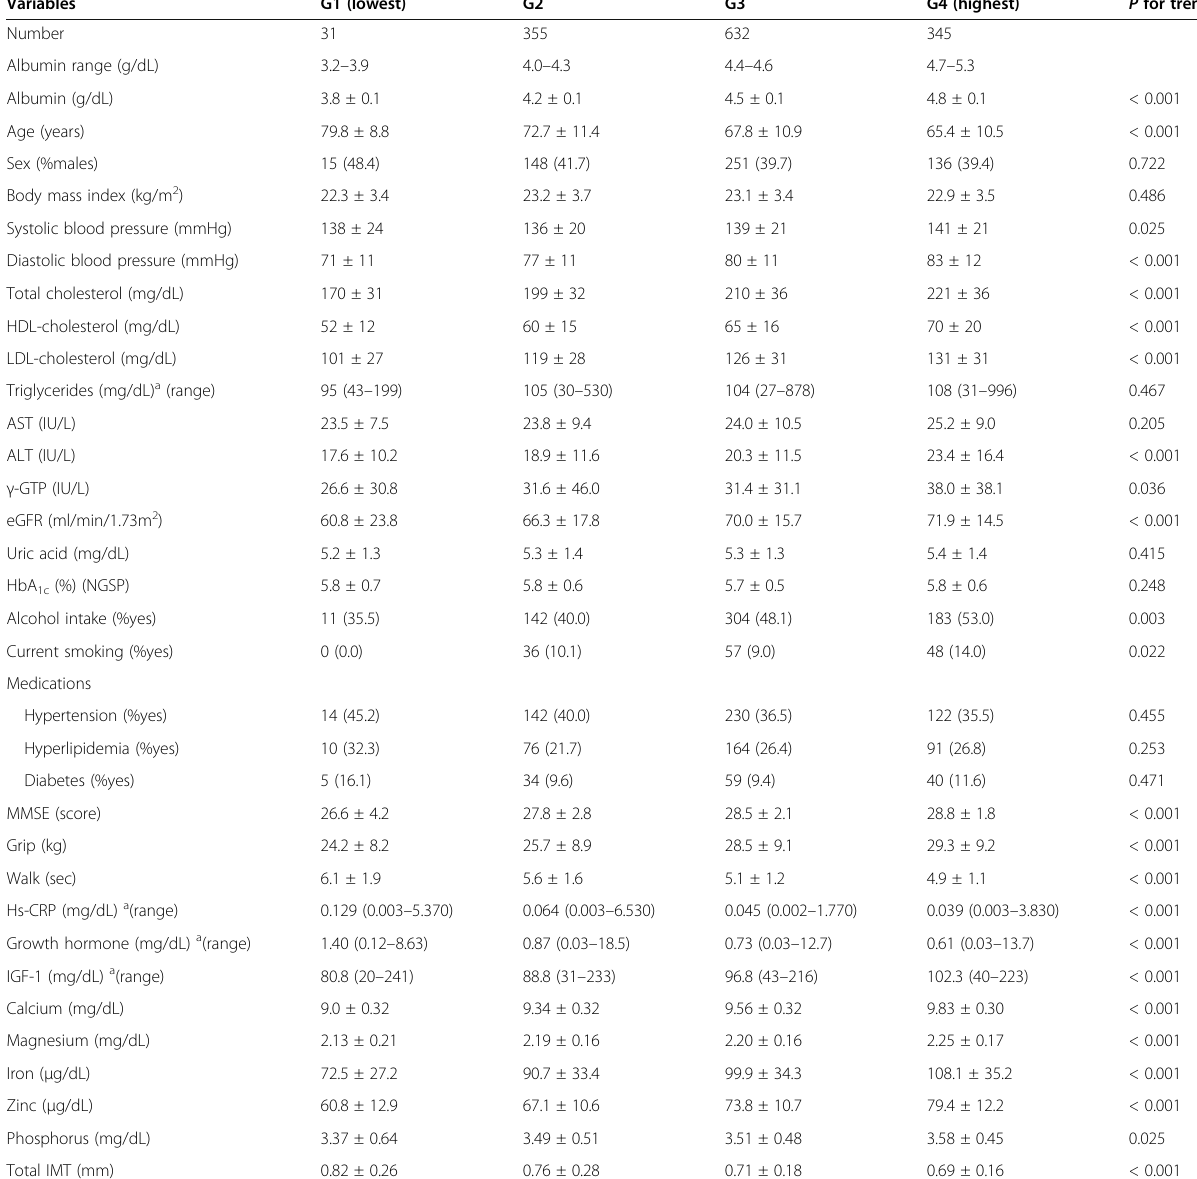
Table 1 Baseline characteristics stratified by serum albumin groups Variables G1 (lowest)